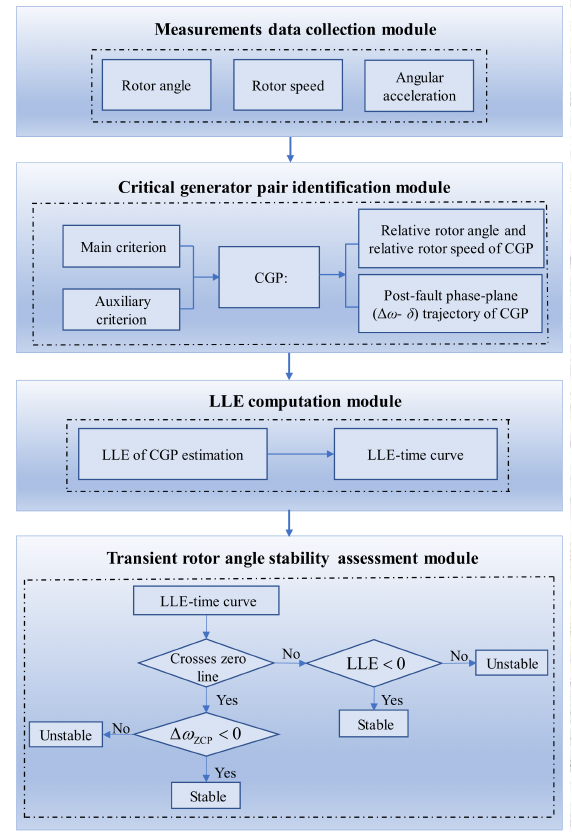
Figure 4. Flowchart of the proposed scheme for online transient rotor angle stability